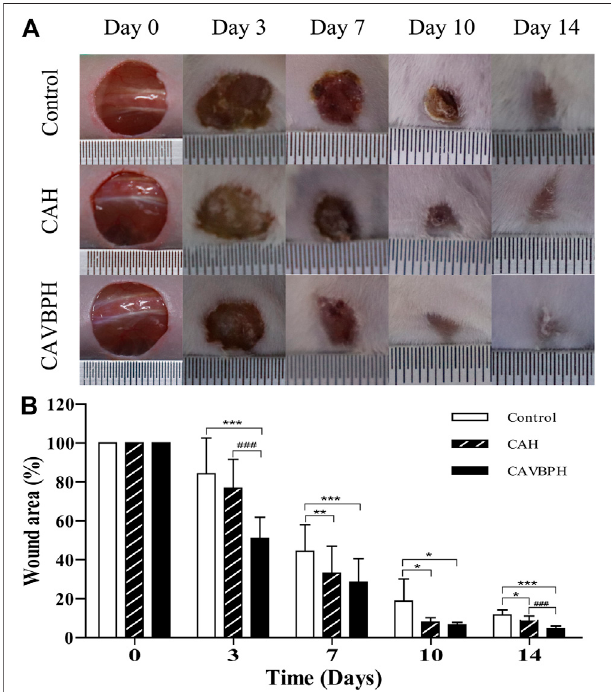
FIGURE 3 | Macroscopic appearance analyses of skin wounds (A) and the wound area (B) in the different groups on days 0, 3, 7, 10, and 14. * p < 0.05,** p < 0.01,*** p < 0.001 vs .controlgroup;# p < 0.05,## p < 0.01,### p < 0.001 vs . CAH group as statistically signi fi